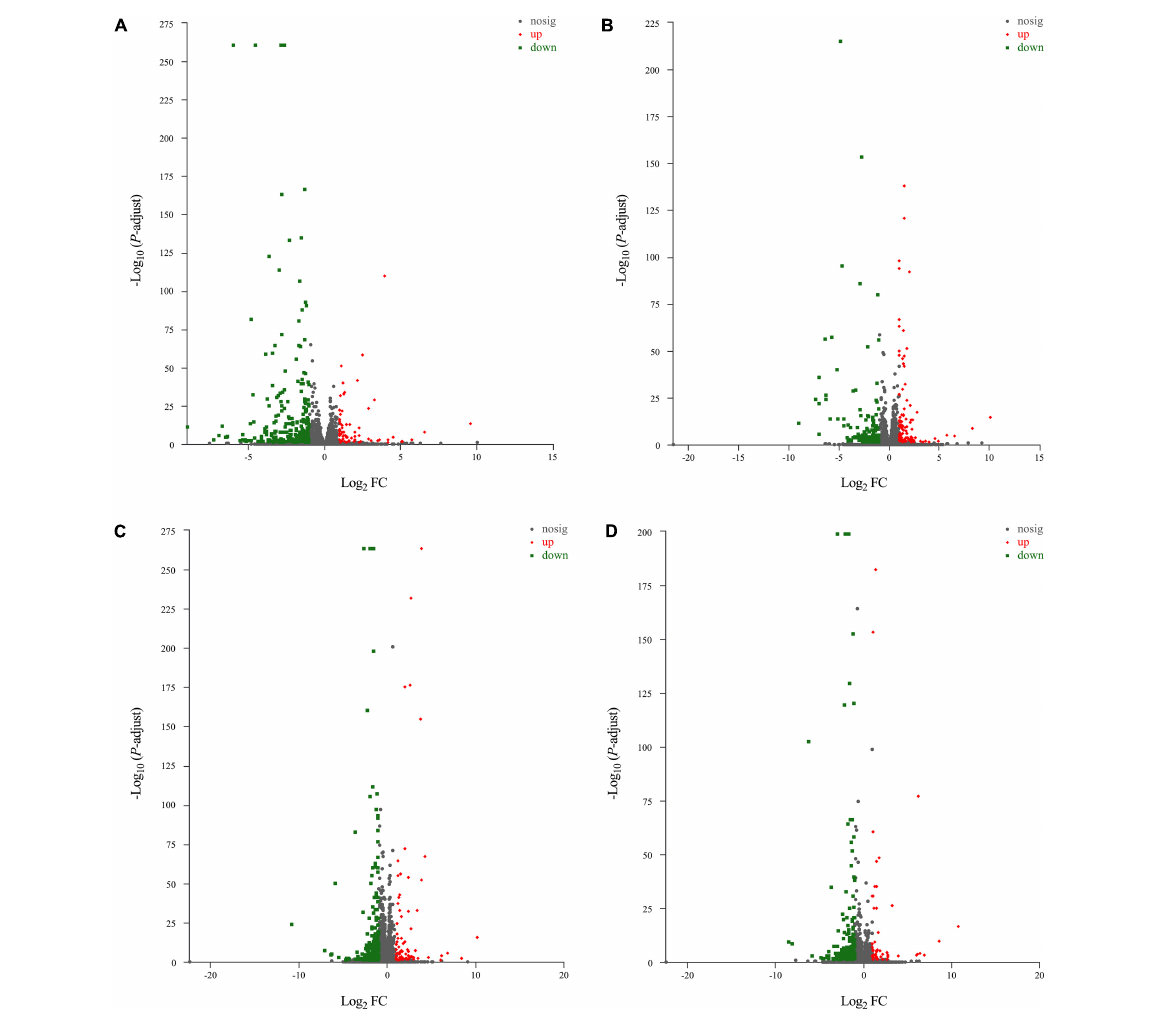
FIGURE4 Volcano map results, the abscissa is the Log 2 FC and the ordinate is the -LOG 10 , P -adjust < 0.05. Results of DRG sequencing, (A) model vs. sham; (B) model vs. tuina; Results of SDH sequencing, (C) model vs. sham; (D) model vs. tuina. Gray are genes with no differential expression, red are genes with up-regulated expression, and green are genes with down-regulated